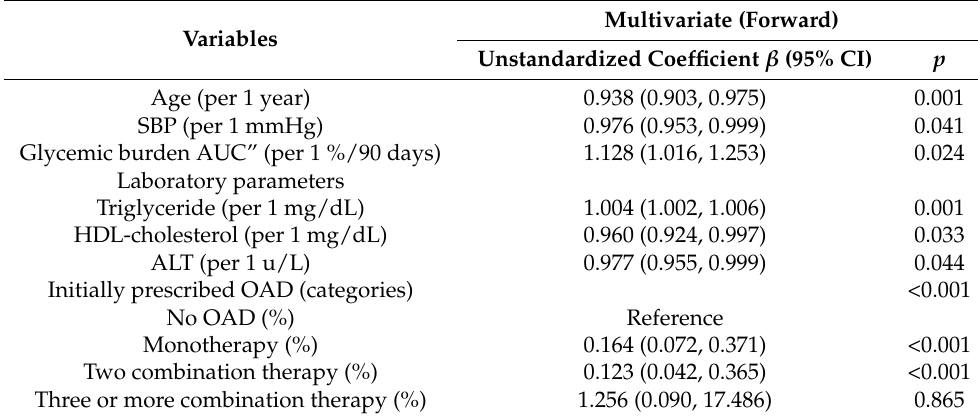
Table 4. Determinants of glycemic burden and other clinical characteristics with treatment fail- ure in initial HbA 1c ≤ 7.0% participants ( n = 267) using multivariable forward Cox proportional hazards